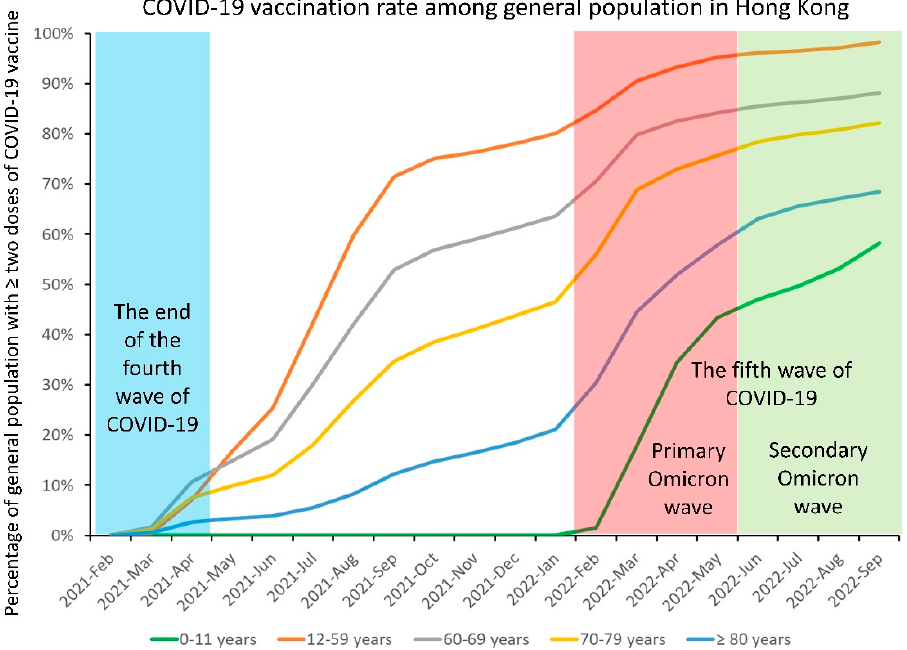
Figure 10. Monthly trend of COVID-19 vaccination rate among the general population until 25 September 2022 (day 1000) in Hong Kong. On 1 August 2022 (day 945), the Scientific Committee on Emerging and Zoonotic Diseases and the Scientific Committee on Vaccine Preventable Diseases of the Centre for Health Protection recommended using CoronaVac for those aged 6 months to under 3 years.